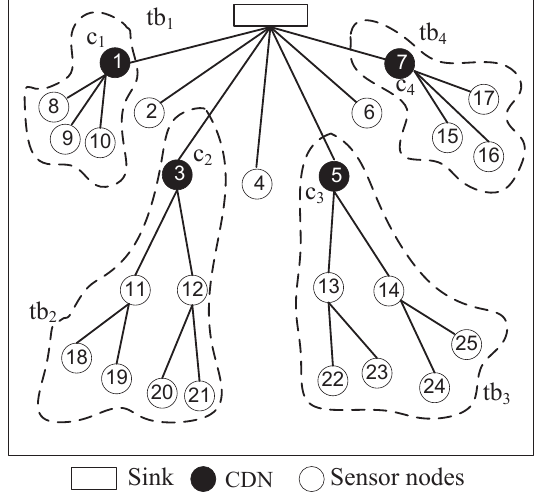
Figure 1. A typical WSN scenario with 4 TBs rooted at 4